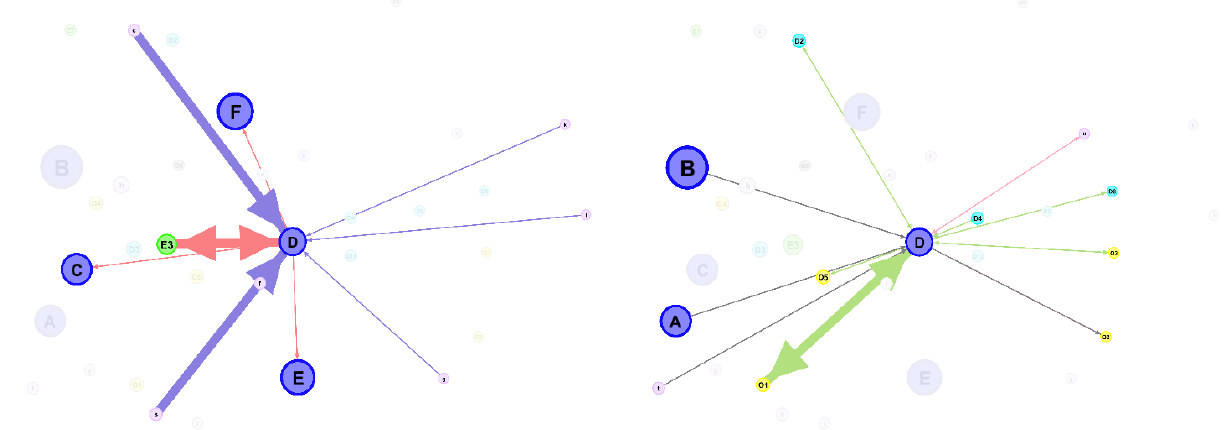
Figure 4. From left to right: Collective learning at the beginning (blue lines) and at the end (red lines) of the realisation phase; collective learning in case of an encountered problem (black line), in case of an interface (pink line), and regularly organised meetings (green